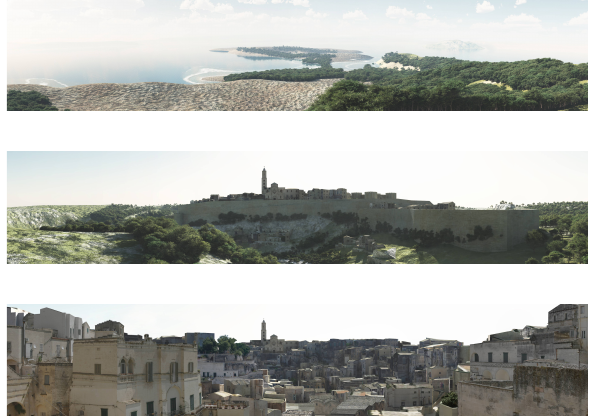
Figure 6. The development of urban historical phases.